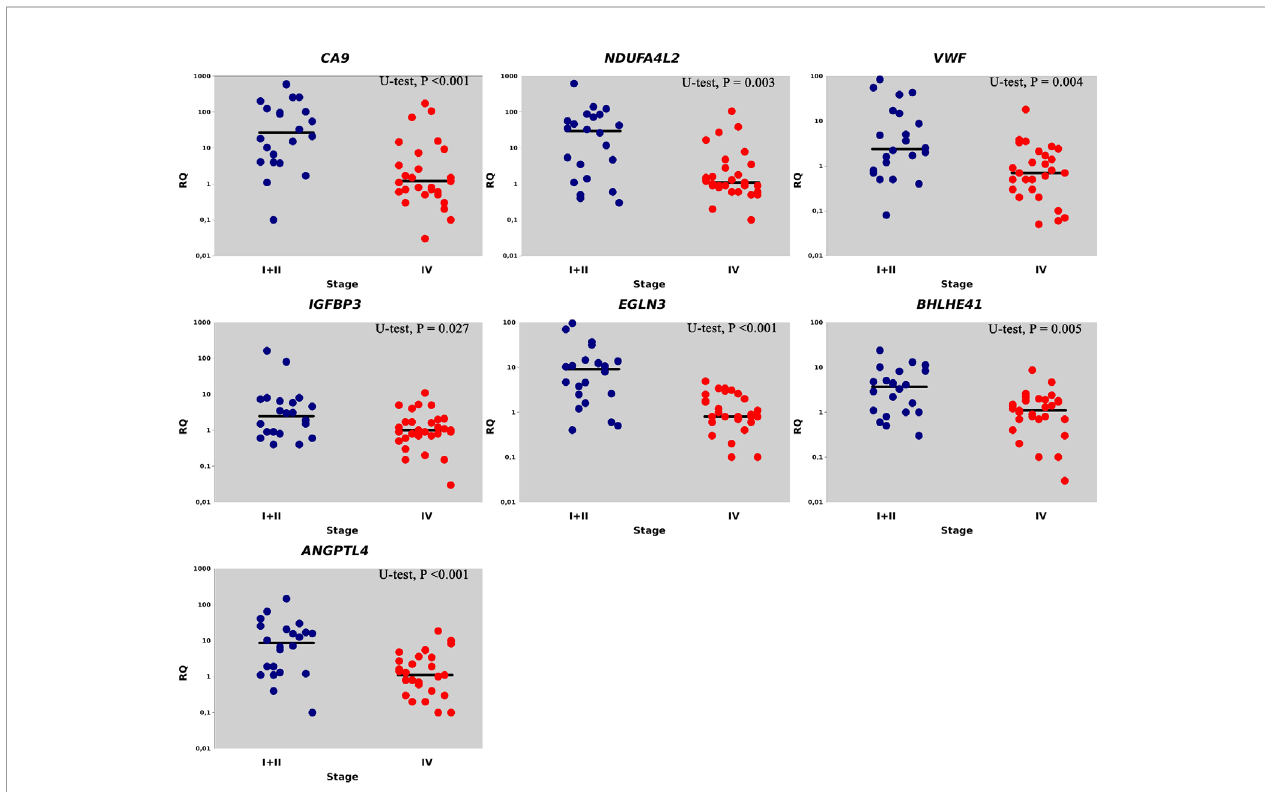
FIGURE 1 | Relative gene expression (RQ) in I + II ( ● ) and IV stages ( ● ). Gene expression values are presented on a logarithmic scale. The line marks the